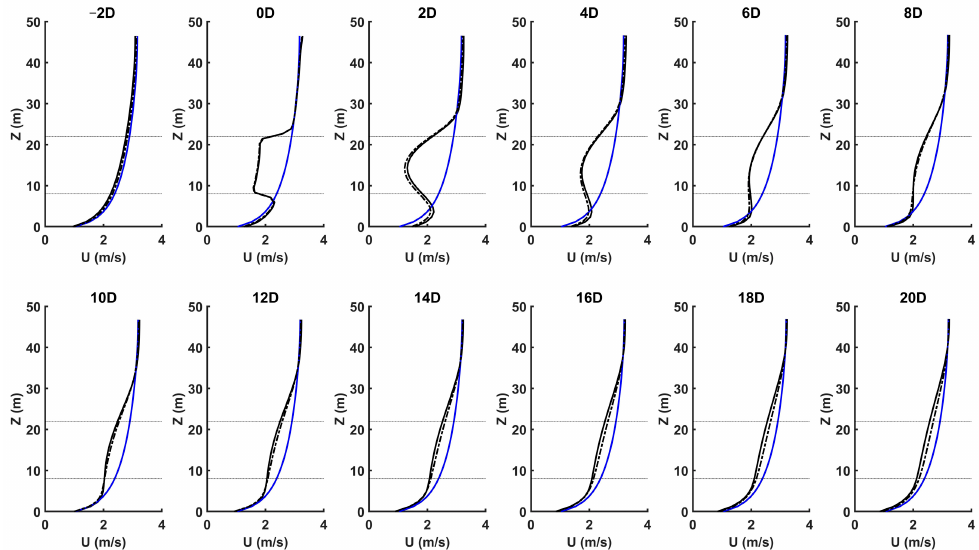
Figure 5. Vertical distribution of the velocity magnitude at different positions along the wake of the turbine located in the middle of the fence (sixth turbine from the left for Δ = 1.5 D and third turbine from the left for Δ = 3 D , Figure 1b,c). Blue lines represent the simulations without turbines. Black lines represent the simulations with turbines. Continuous and dashed lines correspond to a lateral spacing of 1.5 D and 3 D , respectively. The horizontal lines indicate the top and the bottom of the turbines. The velocities have been extracted, at peak flood tide, from the simulation with AD and 𝐾 = 3 ( 𝑎 = 0.33 and 0.34 for Δ = 1.5 D and Δ = 3 D , respectively).